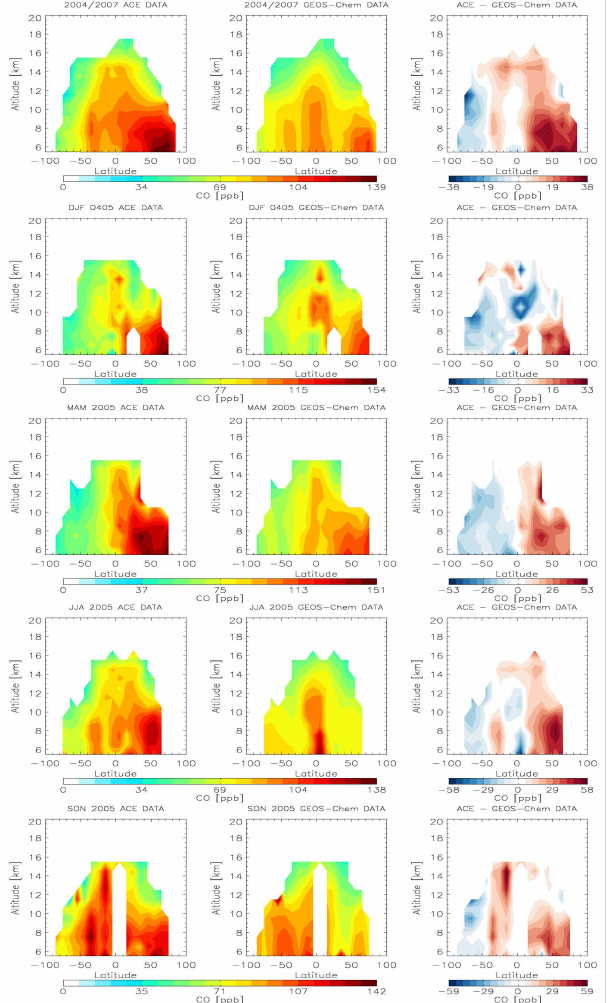
Fig. 8. CO altitude-latitude cross sections from ACE (left column), GEOS-Chem (central column) and difference between both data sets (right column). Top panel 2004–2007 time period, second panel December-January-February 2004/2005, third panel